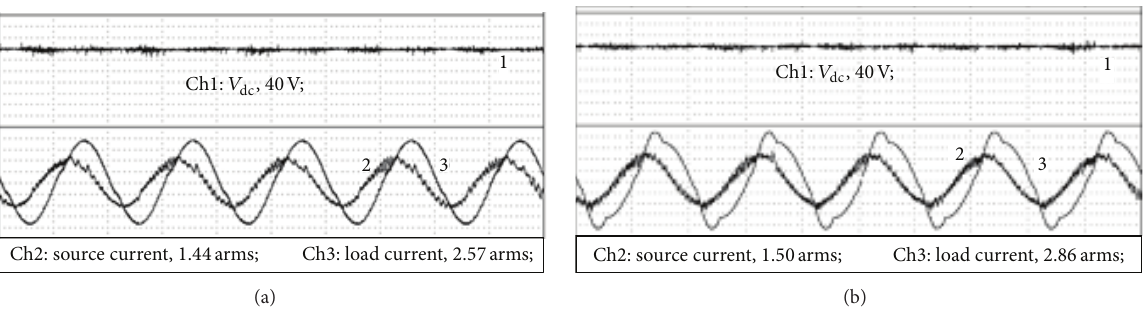
Figure 10: Experimental results of capacitive-coupling VSI (a) without harmonics and (b) with harmonic compensation.